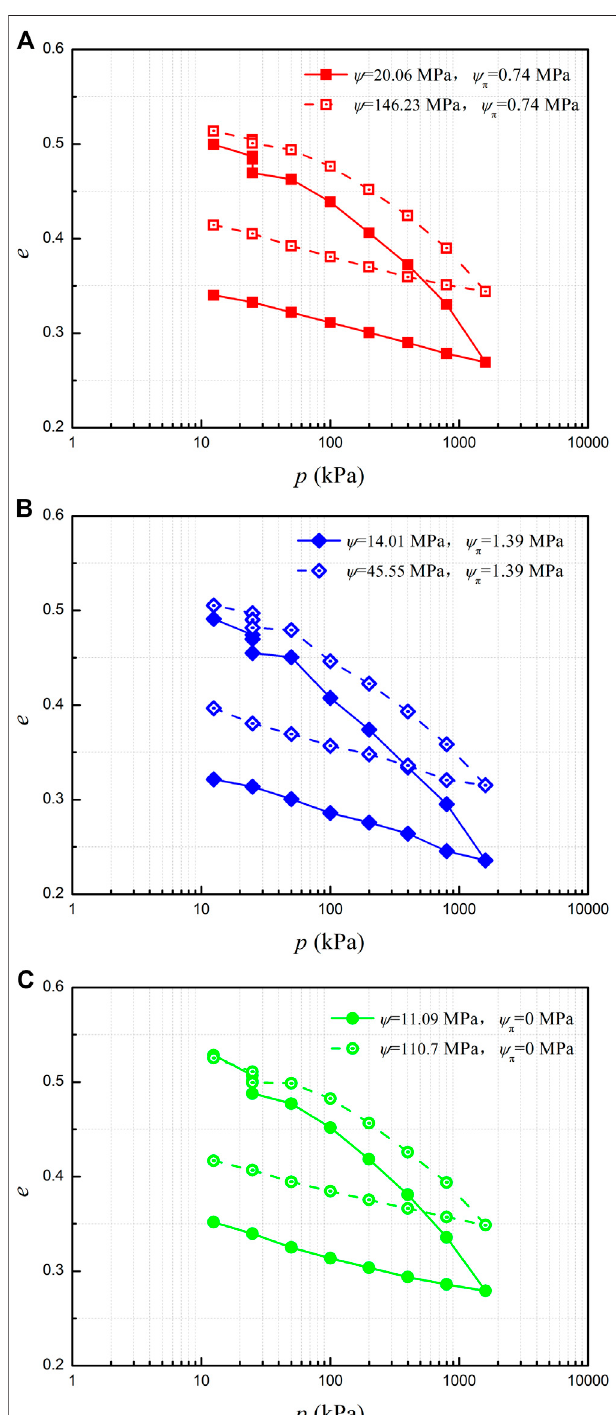
FIGURE 4 | The e -lg p curves of undisturbed loess under total suction and osmotic suction: (A) Ψ π = 0.74 MPa; (B) Ψ π = 1.39 MPa; (C) Ψ π = 0 MPa.